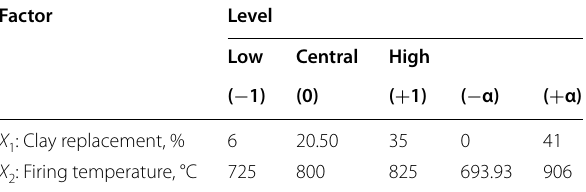
Table 1 Matrix for the CCD Factor Level